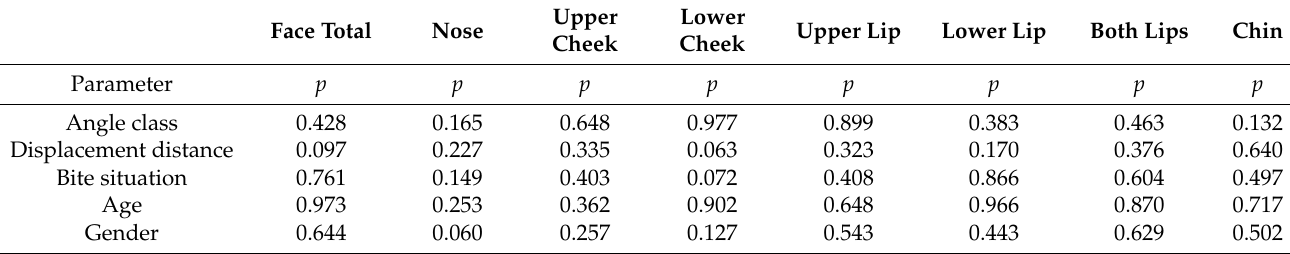
Table 2. Influence of the parameters (angle class, displacement distance, bite situation, age, and gender) on the IO%> Statistical significance was considered at p < 0.05.